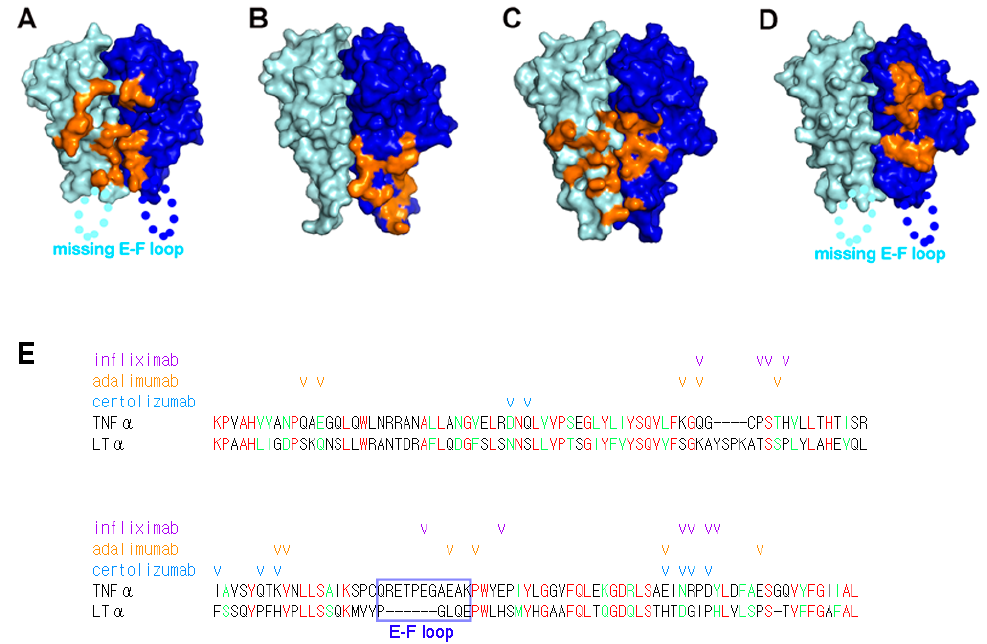
Figure 3. The binding interfaces between TNF α and its antagonists. ( A ) The TNFR2 binding site on the surface of the TNF α trimer (cyan and blue for each protomer) is colored orange; ( B ) The infliximab epitope on the surface of the TNF α trimer (cyan and blue for each protomer) is colored orange; ( C ) The adalimumab epitope on the surface of the TNF α trimer (cyan and blue for each protomer) is colored orange; ( D ) The certolizumab epitope on the surface of the TNF α trimer (cyan and blue for each protomer) is colored orange. The E-F loop, which is missing in the structures of TNF α –TNFR2 and the TNF α -certolizumab complex owing to a lack of interactions, is labeled; ( E ) Structure-based sequence alignment of TNF α and LT α (lymphotoxin α ). The identical and homologous residues are colored red and green, respectively. The E-F loop region is indicated with a blue box and labeled. The TNF α residues involved in the interaction with anti-TNF α antibodies are indicated with check marks colored purple, orange, and cyan for infliximab, adalimumab, and certolizumab, respectively.